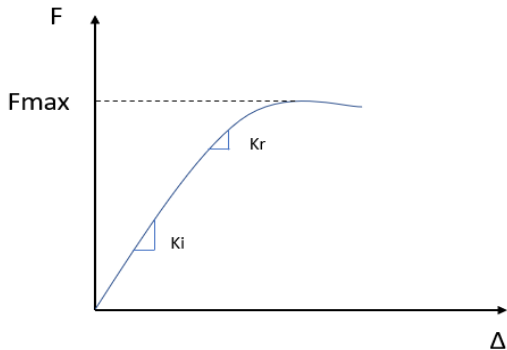
Figure 6. Response variables. Table 5. Response